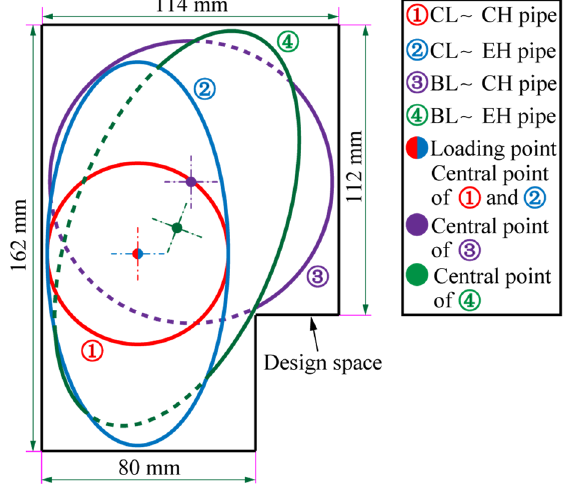
Figure 21. The envelope of four types of pipes in the same design space. ( ① is the circular-helical pipe with center loading, ② is the elliptical-helical pipe with center loading, ③ is the circular-helical pipe with bias loading, ④ is the elliptical-helical pipe with bias loading, the half red and half blue point is the loading point of pipes ① – ④ and the center point of pipes ① and ② ; the purple point is the center point of pipe ③ ; the green point is the center point of pipe ④ ; and pipes ① – ④ are in the optimal configuration for axial stiffness of each type of pipe in this design space). Table 5. Parameters of four types of pipes.